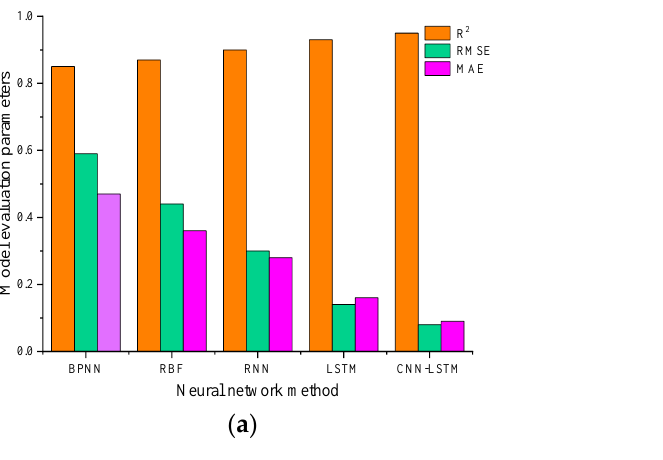
Figure 12. Evaluation of prediction effect of several models. Table 6. Effect evaluation of five models.